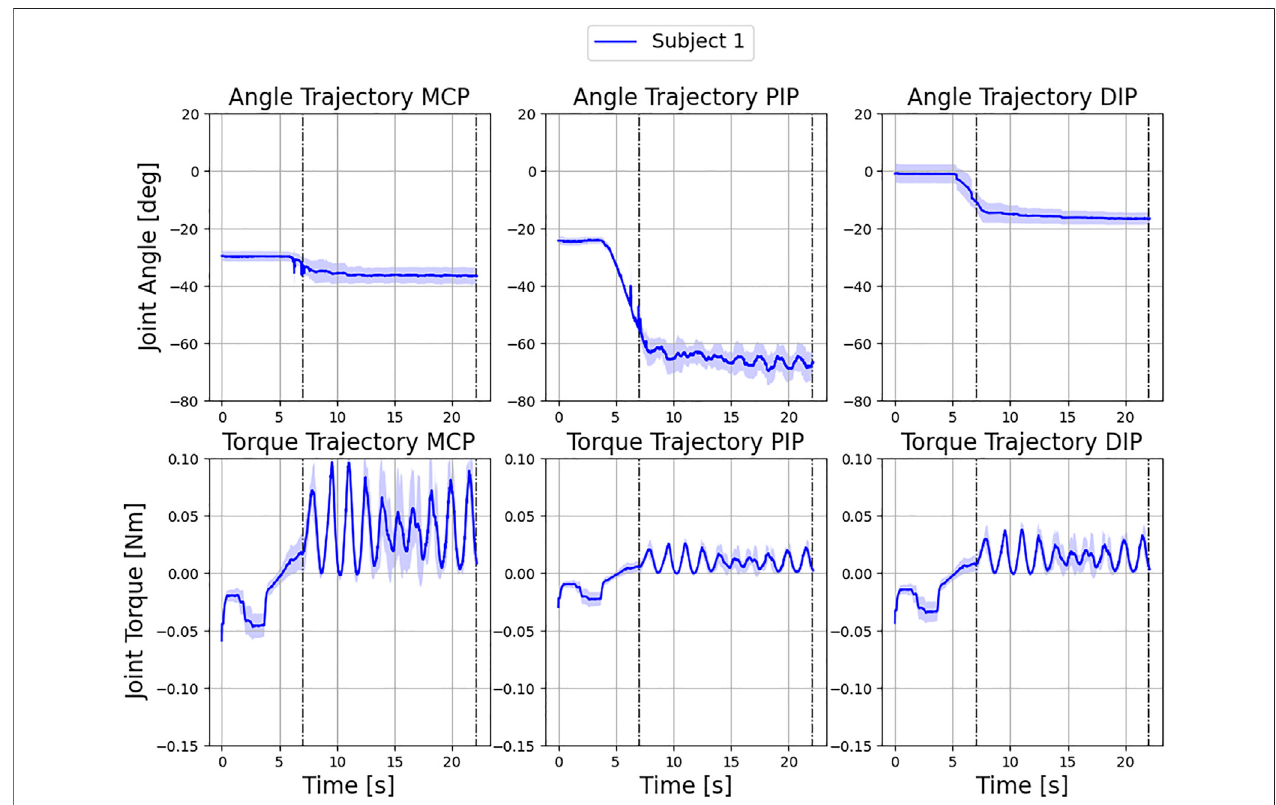
FIGURE14| Controlinterventionforsubject1duringa fl exingmovementoftheindex fi ngerwithatorquelimitof0.1 Nmattheactuatoroverthreeindependenttest cycles.Displayedaretheresultingmean ± standarddeviationoverallcycles.The fi ngerhitsaforcesensitiveplateat7 s,whichmeasuresamaximumexternalforcetothe fi ngertip of 1.53 ± 0.1